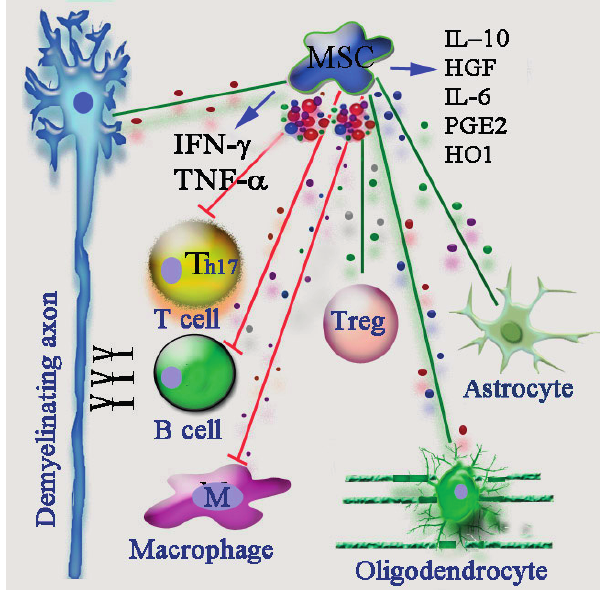
Figure 1. The complex immunomodulatory functions of mesenchymal stem cells (MSCs) in the treatment of multiple sclerosis (MS). The different immune regulatory mechanisms, including pathogenic B cells, Th17 cells, macrophages, and beneficial regulatory T cells (Treg) are involved in shaping the MS pathology. Injection of MSCs improves experimental autoimmune encephalomyelitis (EAE) by imparting severe inhibitory effects (red lines in the picture) on performance of T cells, B cells and macrophages, through secretion of soluble factors, such as IFN- γ , TNF- α , IL-10, HGF, IL-6, PGE2 and HO1. MSCs can also promote an anti-inflammatory effect through promotion of Treg proliferation (green line). In addition, MSCs also positively modulate the functions of astrocytes, oligodendrocytes, and neuronal axons. HGF: hepatocyte growth factor; PGE2: prostaglandin E2; HO1: heme oxygenase